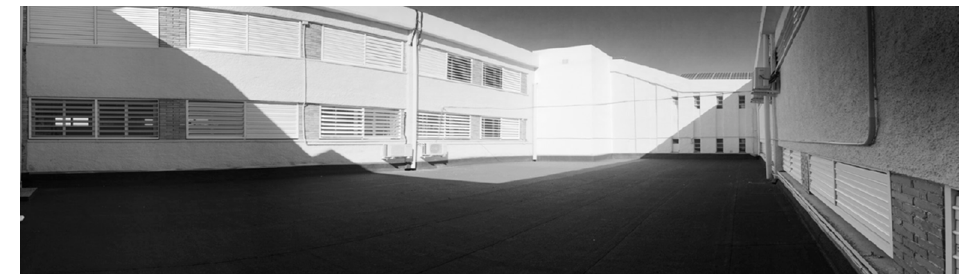
Figure 2. Case study 1: Courtyard overview.